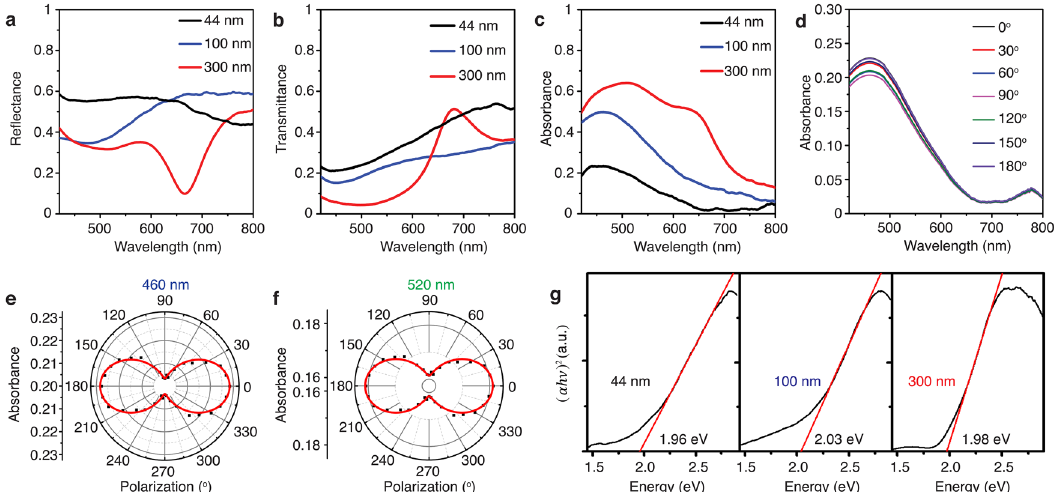
Fig. 4 Linear optical absorption of lengenbachite fl ake. a – c Re fl ectance, transmittance, and absorbance spectra of lengenbachite fl akes of three different thicknesses 44, 100, and 300 nm. d Absorbance spectra from the 44 nm-thick lengenbachite fl ake as a function of the incident linear polarization angle between 0° and 180°. e , f Evolution of the absorbance as a function of the linear polarization angle at two different wavelengths of 460 and 520 nm. g Tauc plots for the direct optical band gap extraction of three lengenbachite fl